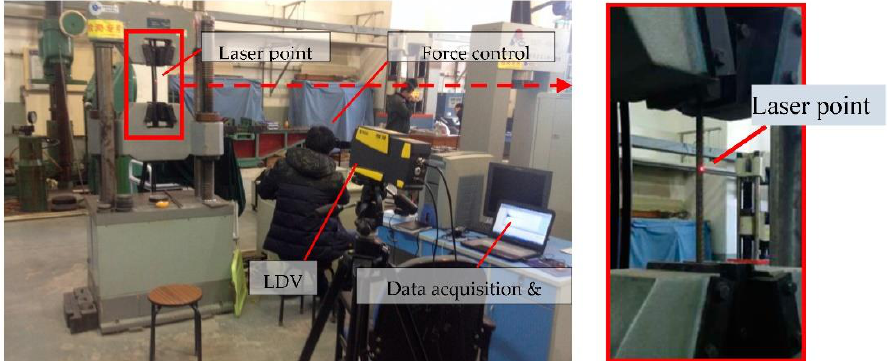
Figure 3. Experiment operation for testing vibration frequency by using LDV.